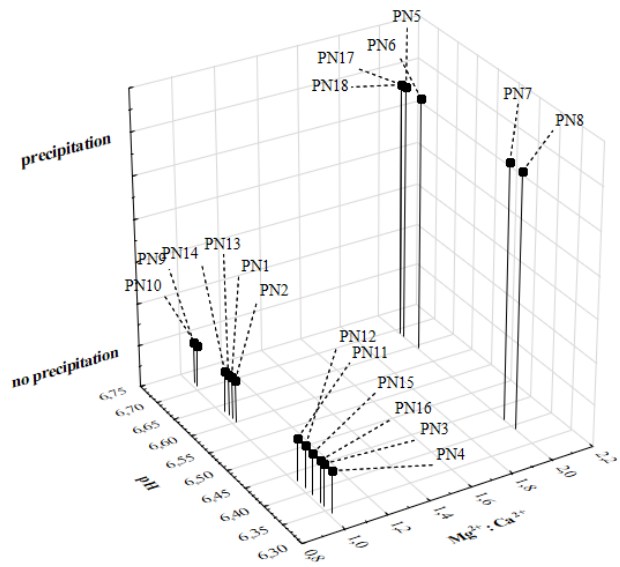
Figure 3. Relationships between the pH of the PN admixtures, the molar ratio of magnesium and calcium ions, and observations concerning precipitation.